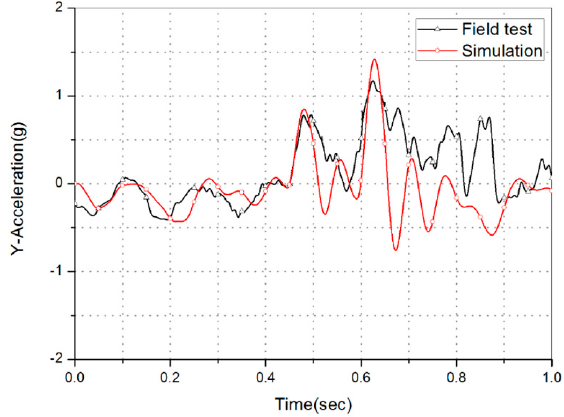
Figure 26. The comparison of Y-acceleration (lateral) between the field test and the simulation.